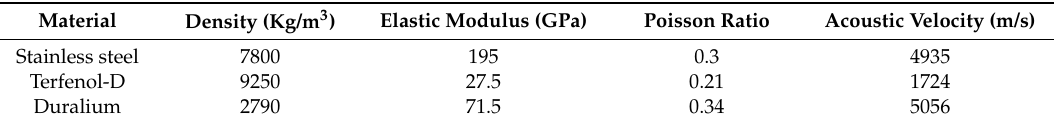
Table 1. Material parameter of duralumin, Terfenol-D and stainless